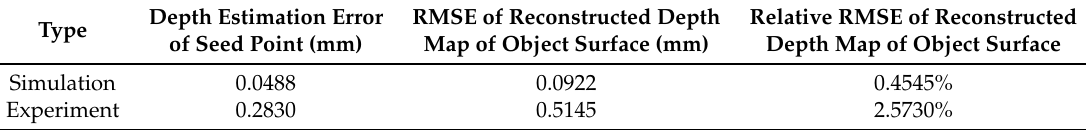
Figure 14. Comparison of the results in the simulation and experiment. ( a ) Ground truth depth map of the object surface. ( b ) Reconstructed depth map based on the centroid pixel of the specular highlight region in the simulation. ( c ) Reconstructed depth map based on centroid pixel of the specular highlight region in the experiment. Table 3. Comparison between the simulation result and the experimental